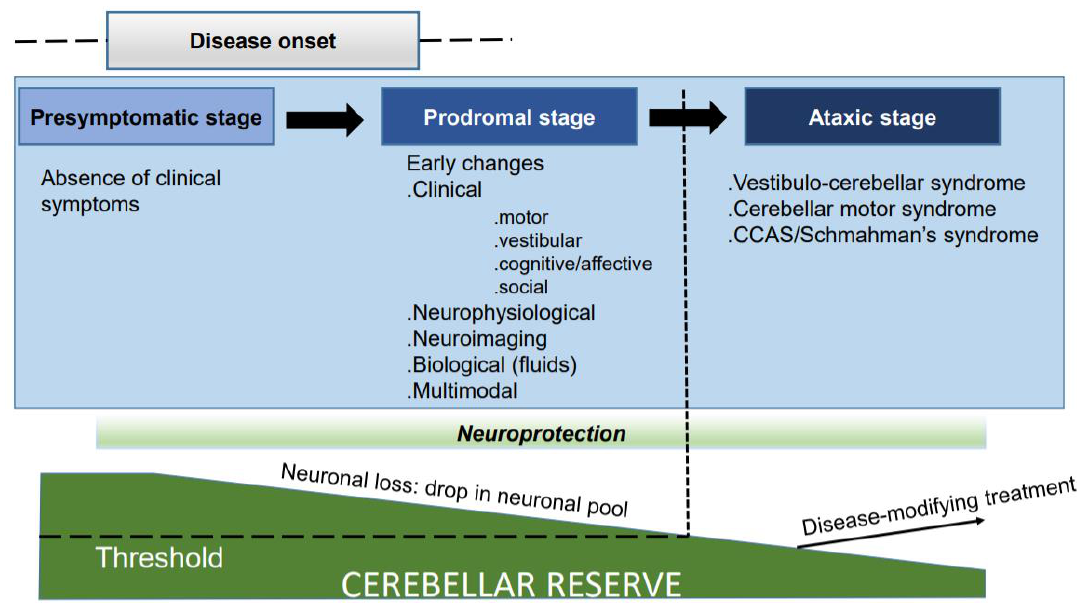
Figure 1. Progression of the disease from the pre-symptomatic state to the ataxic